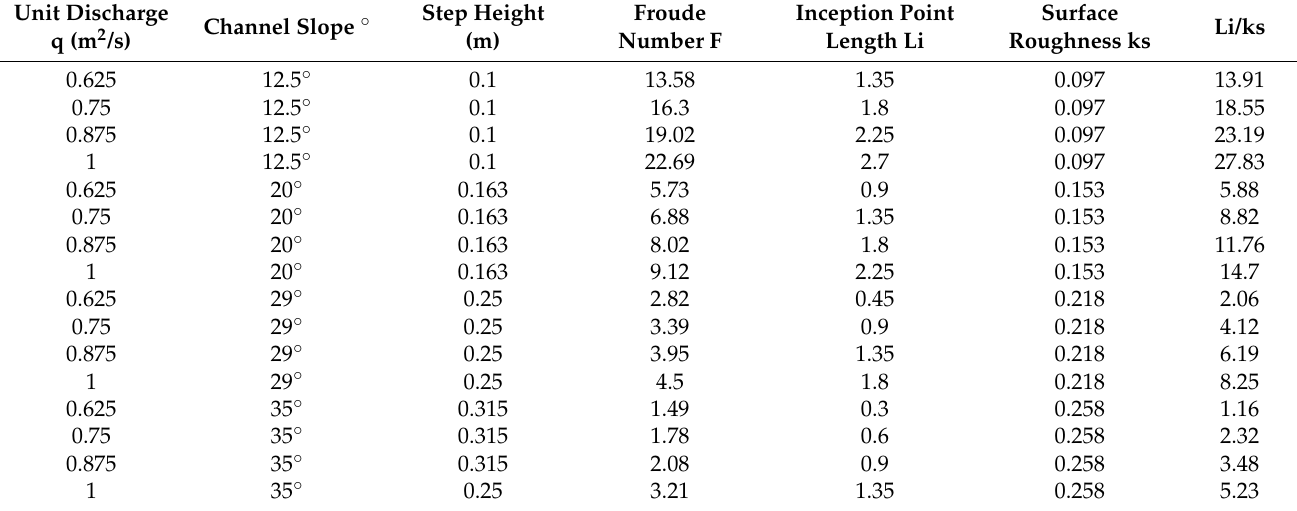
Table 2. Table of unit discharge (q), step height, inception point (Li), and normalized Li for 12.5 ◦ , 20 ◦ , 29 ◦ , and 35 ◦ stepped spillways.